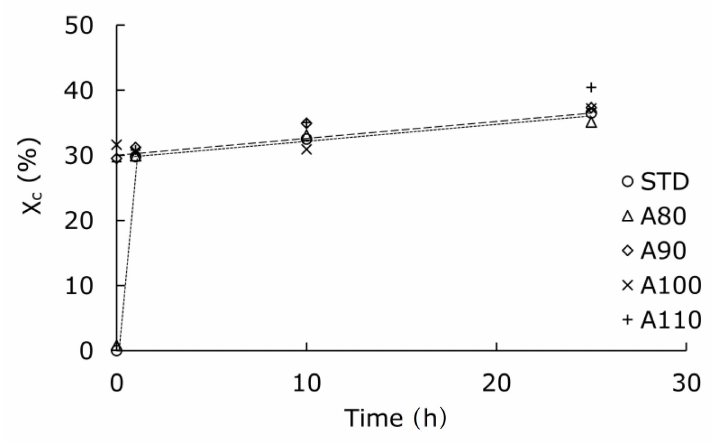
Figure 5. Changes in crystallinity during hydrolysis at 70 °C and 95% RH for PLA annealed at various temperatures.